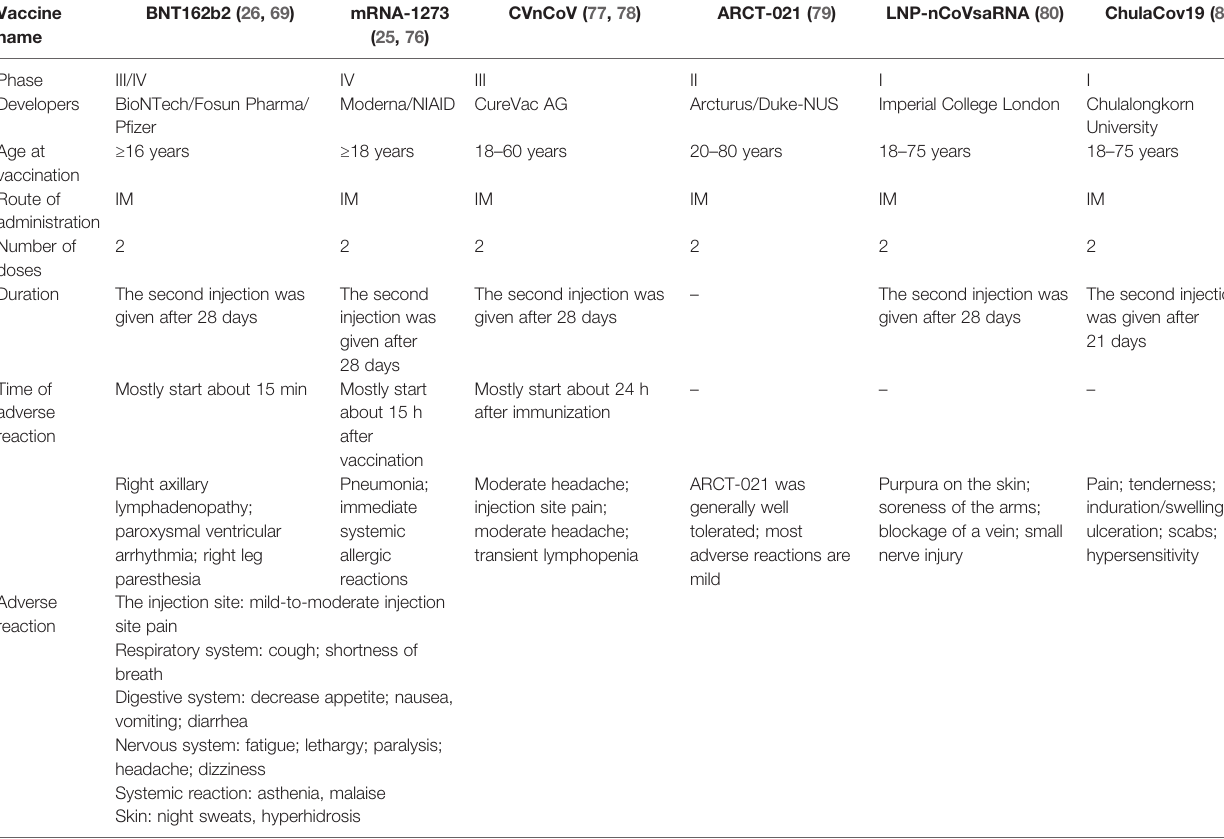
TABLE 1 | The common adverse reactions of mRNA vaccine candidates in clinical trials. Vaccine